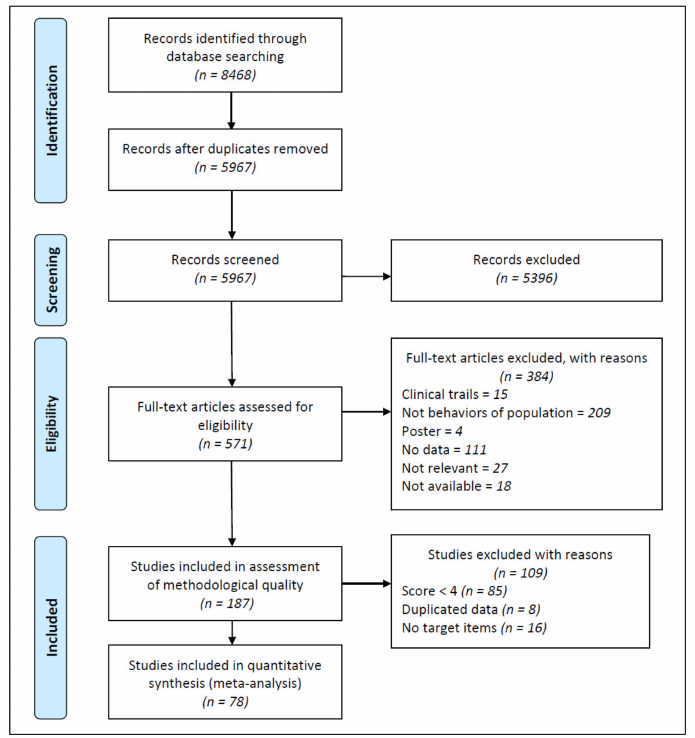
Figure 2. Flow diagram of study